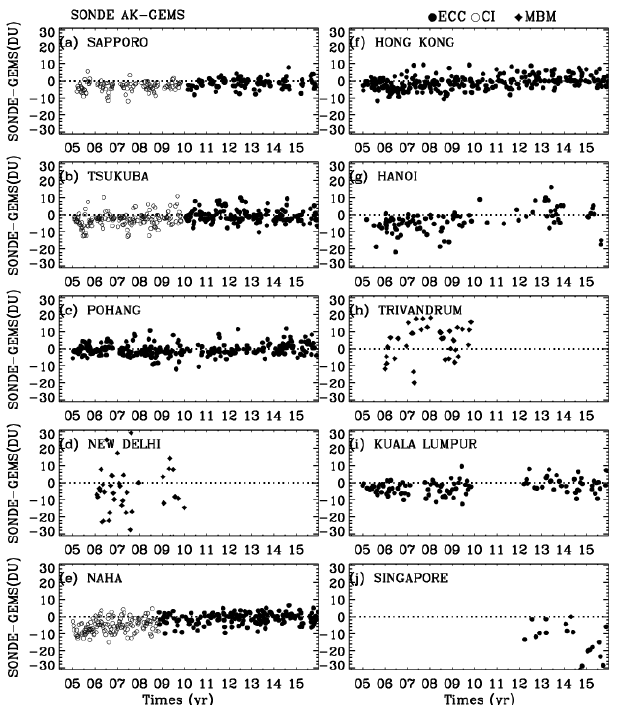
Figure 6. Same as Fig. 5 but for absolute differences of tropo- spheric ozone columns (DU) between ozonesonde measurements and GEMS-simulated retrievals.